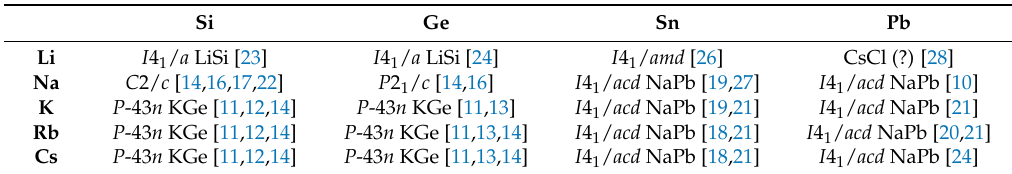
Table 1. Binary phases of alkali metal (Li-Cs) and group 14 element with 1:1 stoichiometric ratio (ambient